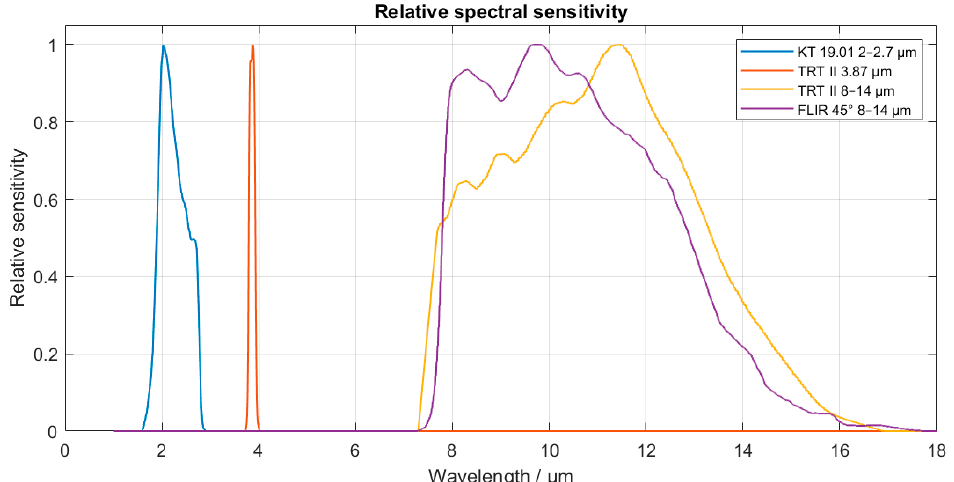
Figure 5. Spectral sensitivity of Heitronics KT19.01 and the high and the low temperature range of Heitronics Transfer Radiation Thermometer II (TRT II), digitized from Heitronics pyrometer documentation [29], and generic spectral sensitivity of vanadium oxide (VOx)-based microbolometer detectors of FLIR thermal imagers with 45° fi eld-of-view optics [30].